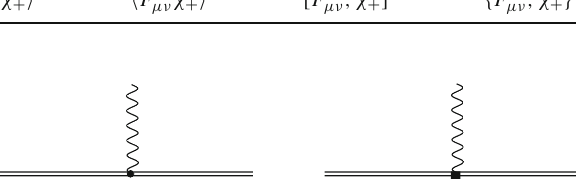
with L the number of loops and N M